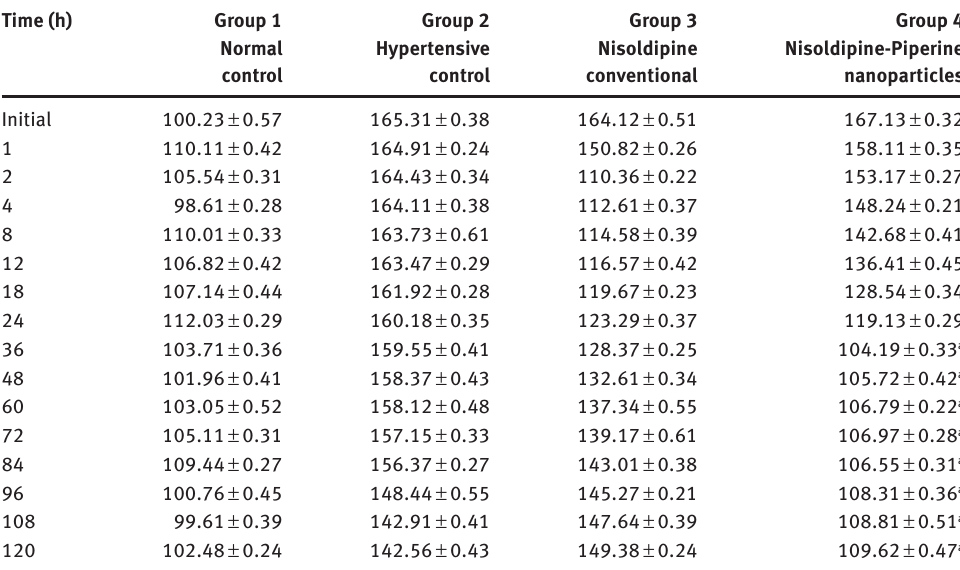
Table 6: Antihypertensive effect of optimized nisoldipine-piperine nanoparticles and conventional formulation. Time (h)